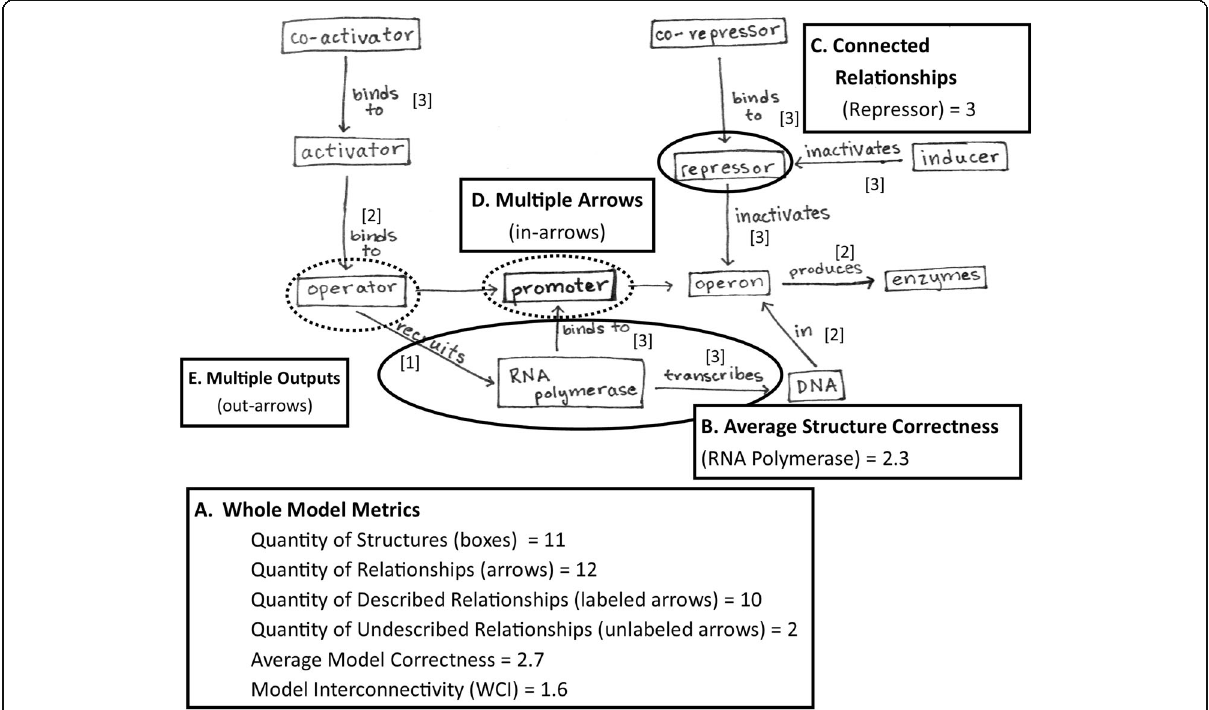
Fig. 2 Student-generated conceptual model with annotations of how models were analyzed. Correctness scores (1 is incorrect, 2 is correct but lacking technical accuracy, 3 is scientifically accurate) are shown in brackets next to each described